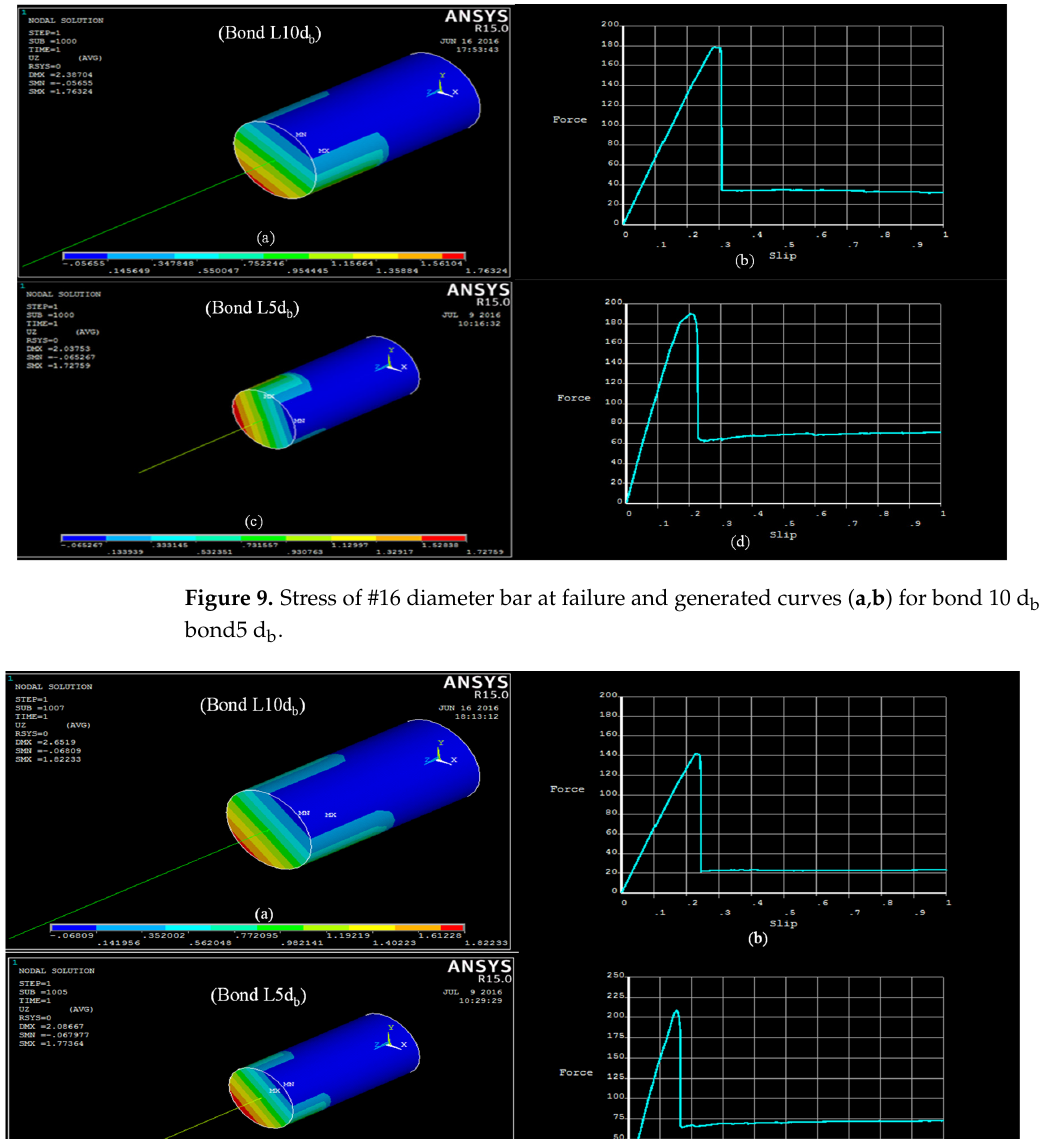
Figure 8. Stress of #13 diameter bar at failure and the generated curve ( a , b ) for bond 10 d b and ( c , d ) for bond 5 d b .